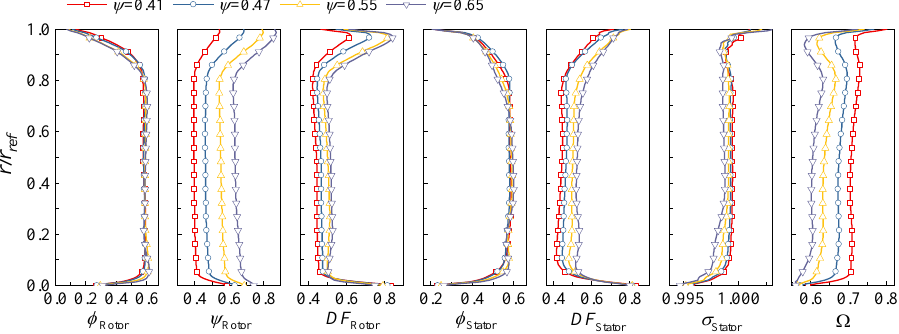
Figure 12. Radial characteristic for different compressor stages: design point.